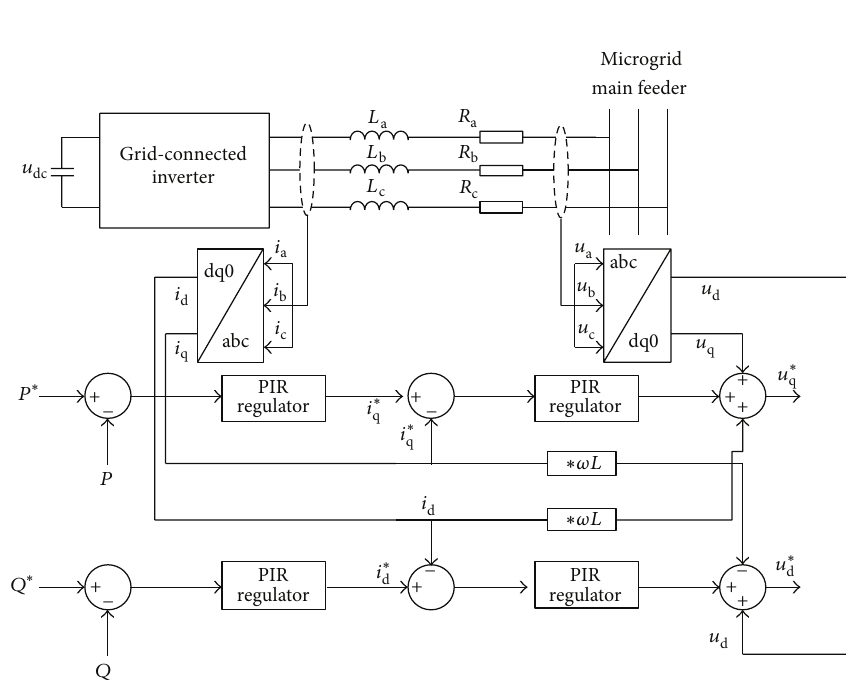
Figure 5: Sub-microgrid inverter control